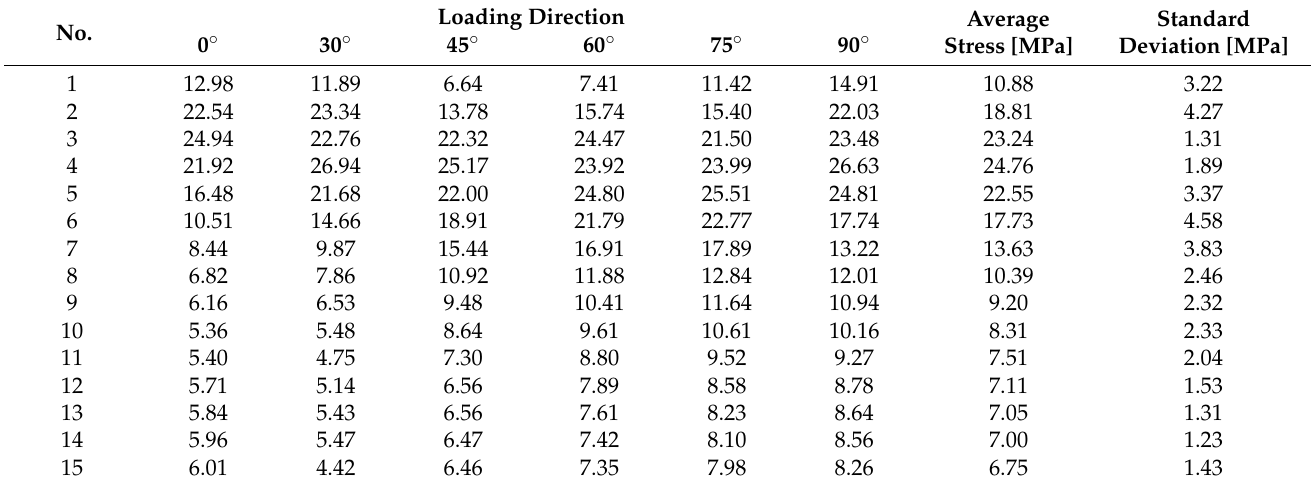
Table 6. Stress values in restoration